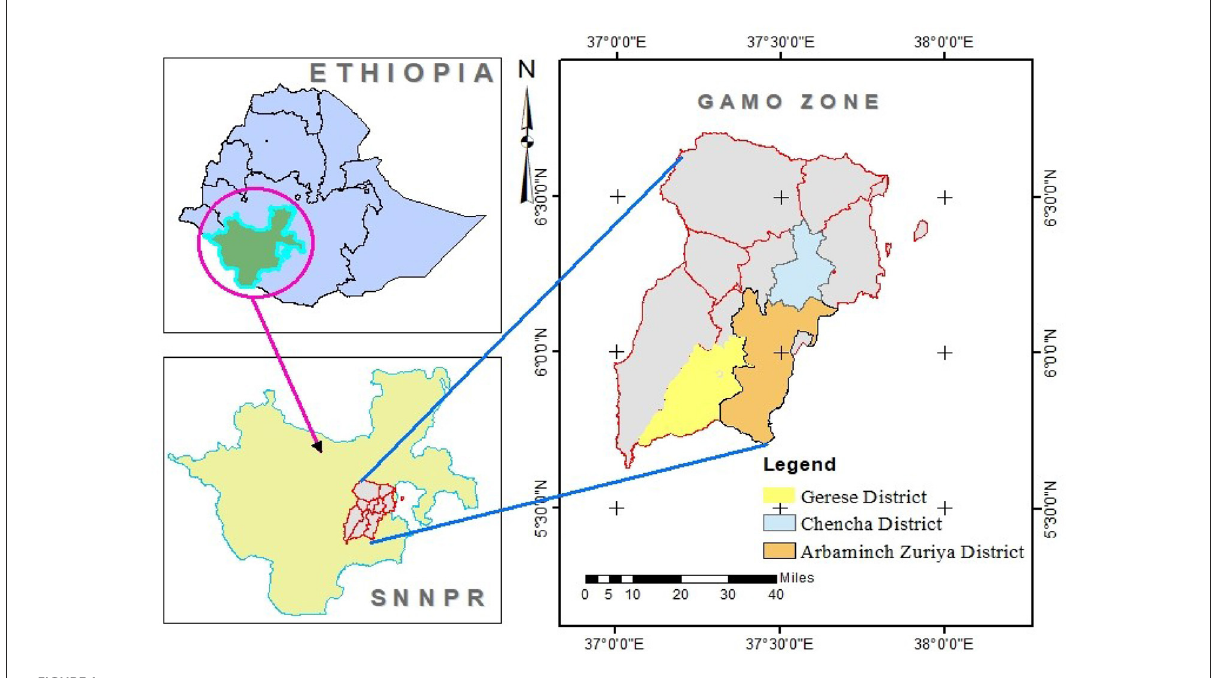
FIGURE1 Map of the study